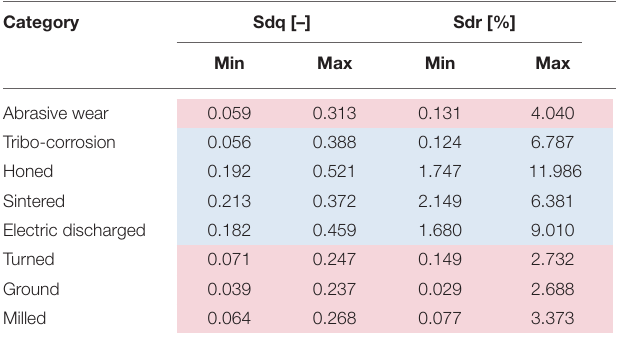
TABLE 1 | Value ranges associated with the machining and wear categories on the Sdq-Sdr map.